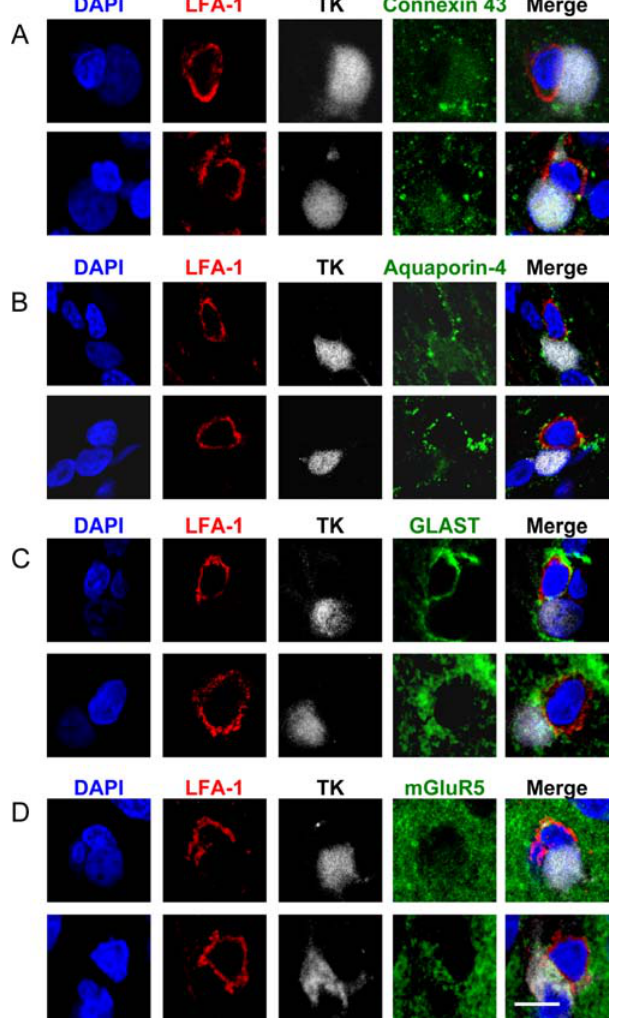
Figure 7. The glutamate transport protein GLT-1 is excluded from the astrocyte membrane area directly opposed to the c-SMAC zone of the Kupfer-type immunological synapse. Confocal images of three Kupfer-type immunological synapses are shown. The top row for each synapse shows images of markers specific for nuclei (DAPI, blue), glutamate transporter (GLT-1, green), T cell adhesion protein (LFA-1, red), viral infection (TK, white), or the superposition of all four color channels (Merge). Bottom rows show fluorescence intensity graphs of GLT-1 and LFA-1 along the path indicated by the white arrow. 3-D reconstructions of the interface of the immunological synapse are shown on the right of the bottom rows with markers specific for GLT-1 and LFA-1. Note the characteristic peripheral distribution of LFA-1 on the T cell (p-SMAC) and a similar peripheral distribution of GLT-1 on the post-synaptic astrocyte. Fluorescence intensity graphs confirm a similar peripheral distribution pattern of LFA-1 and GLT- 1. The peripheral area of the interface is indicated by arrows 1 and 3, and the center of the interface by arrow 2 in both confocal images and fluorescence intensity graphs.